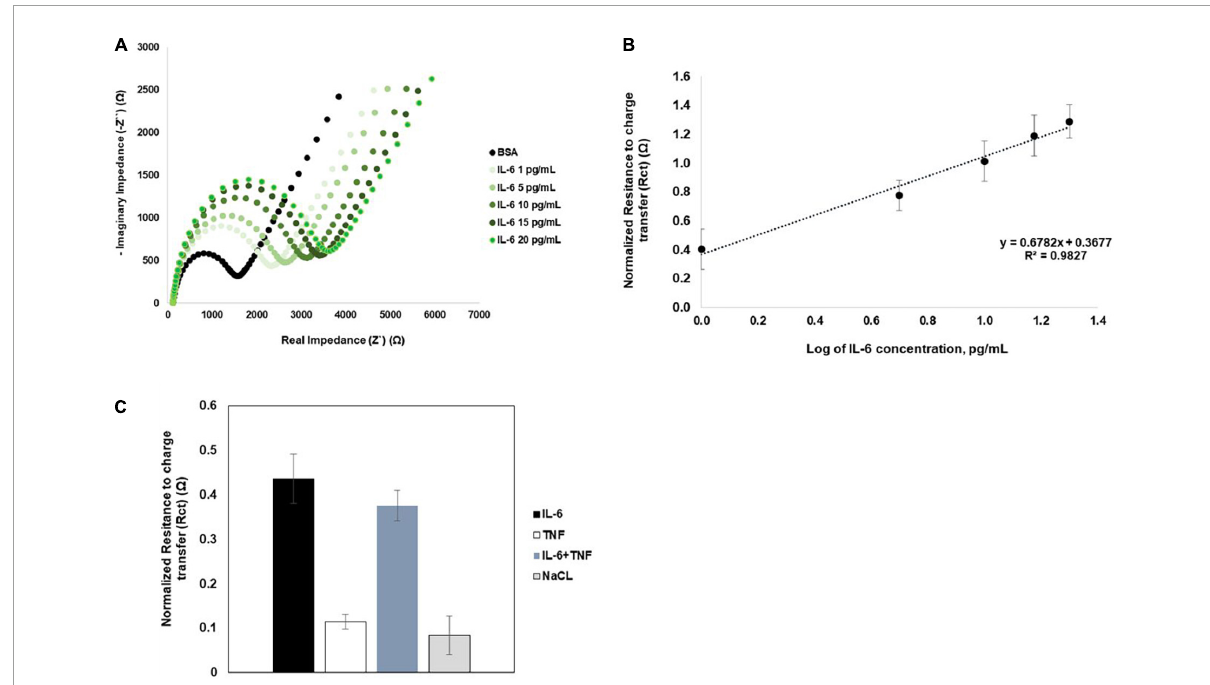
FIGURE3 Nyquist plots and biosensor calibration curves. (A) Representative Nyquist plots of increasing concentrations of IL-6. (B) The calibration curves for IL-6 was obtained from an average of six independent sensors ( n = 6). Error bars correspond to SD. (C) Immunosensor selectivity and specificity was analyzed by comparing normalized Rct values obtained for IL-6 or TNFa spiked in 0.9% NaCl; IL-6 spiked in a cocktail solution with TNF α , and for 0.9% NaCl solution ( n =